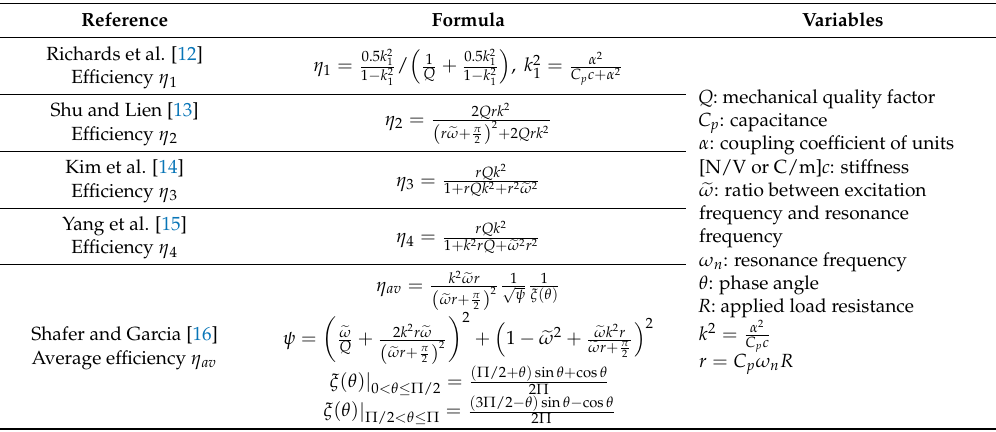
Table 1. Expressions to estimate the efficiency of the energy